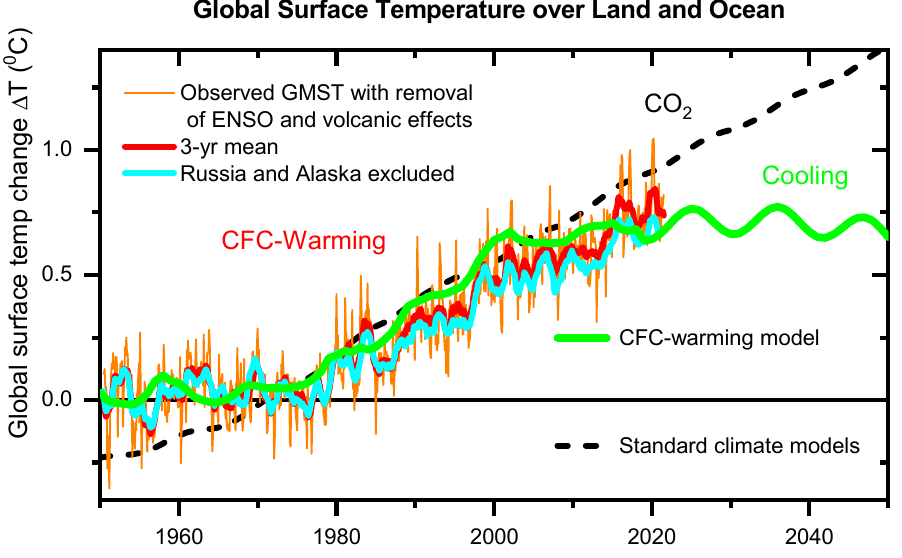
Figure 8. Observed and theoretical GMSTs. Observed GMST data were from the UK Met Office’s combined land surface air temperature and sea surface temperature anomalies (HatCRUT4.6); the curves in red and cyan are, respectively, 3-point averages of observed data with and without the inclusion of Russia and Alaska. The theoretical GMSTs (the curve in green) were calculated by the CFC-warming model, including the contribution of all halogenated GHGs and the 11-year cyclic variation in ±0.05 °C due to solar cycles. For comparison, the simulated GMSTs by standard climate models (dashed curve in black) are also shown [5].